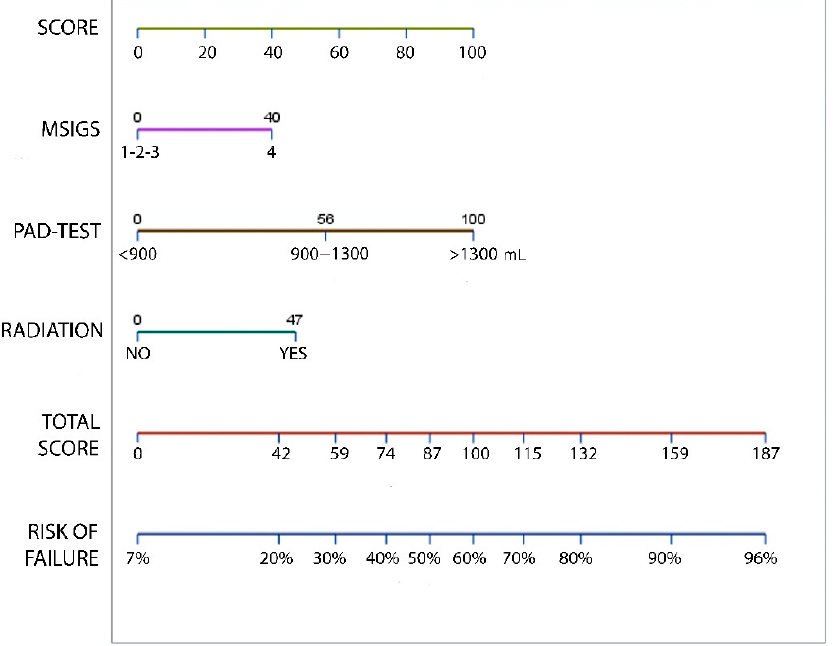
Figure 5. Nomogram predicting the probability of ATOMS failure, which can be calculated by obtaining the value for each parameter by drawing a straight line to the point axis, adding the points together, and finding the sum on the total point axis.